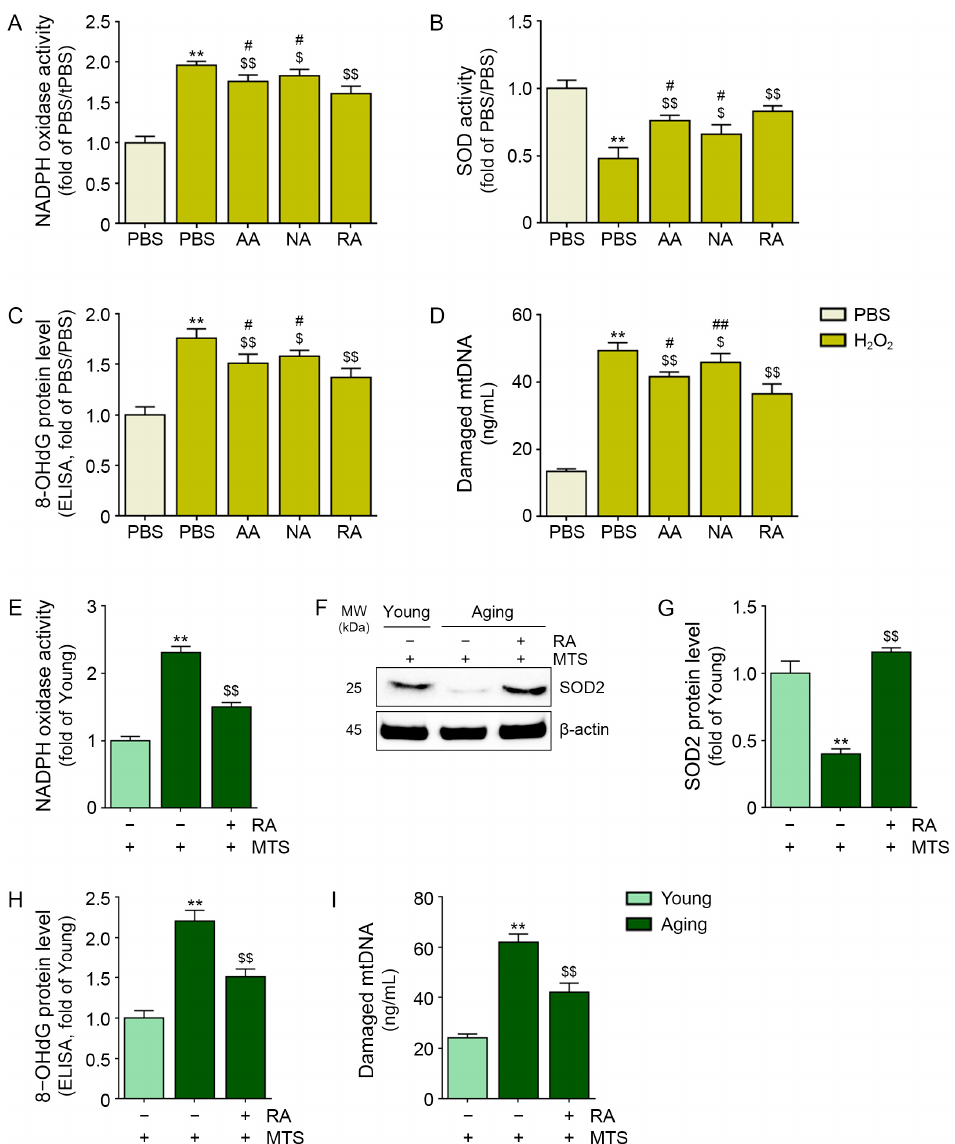
Figure 1. RA treatment decreased oxidative stress in H 2 O 2 -treated keratinocytes and aged mouse skin. ( A , E ) The NADPH oxidase activity in H 2 O 2 -treated keratinocytes ( A ) and aged mouse skin ( E ) was detected by an assay. The NADPH oxidase activity increased in H 2 O 2 -treated keratinocytes and aged mouse skin but decreased after RA treatment. ( B , F , G ) The SOD level in H 2 O 2 -treated keratinocytes ( B ) and aged mouse skin ( F , G ), as confirmed by the activity assay and western blot. The SOD level decreased in H 2 O 2 -treated keratinocytes and aged mouse skin but increased after RA treatment. ( C , H ) The 8-OHdG level in H 2 O 2 -treated keratinocytes ( C ) and aged mouse skin ( H ) was confirmed by ELISA. ( D , I ) The presence of damaged mtDNA in H 2 O 2 -treated